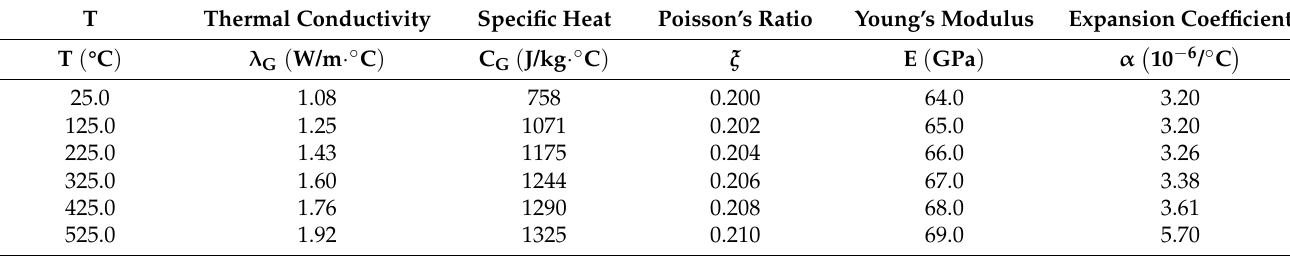
Table 2. Properties of Borofloat 33 glass material [21].